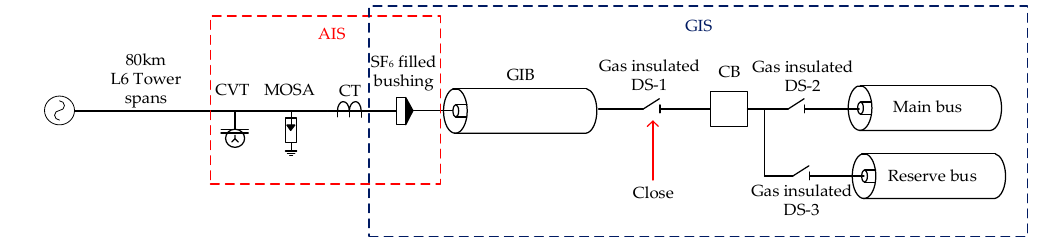
Figure 8. Detailed circuit model. Energies 2020 , 13 , x